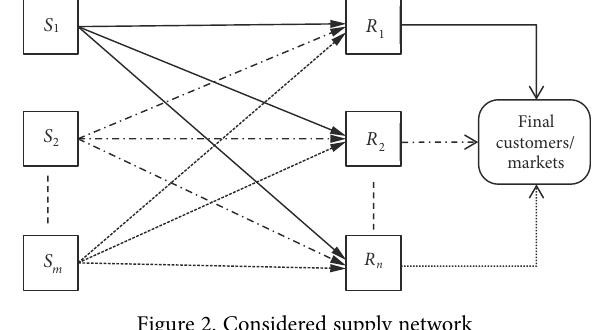
Figure 2. Considered supply